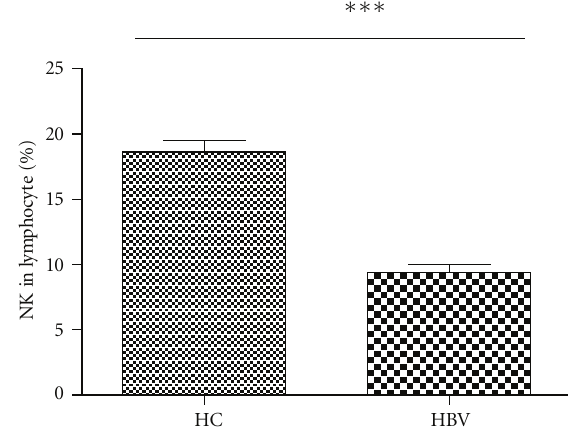
Figure 2: Characterization of NK cells at baseline. The percentages of NK cells in lymphocytes. Data are expressed as mean ± SEM. ∗∗∗ P < 0 . 001.